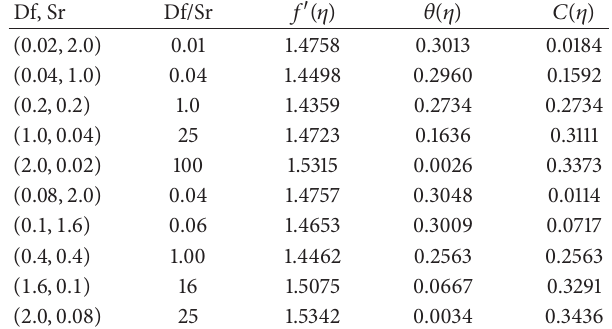
Table 1: Comparison of present results with values obtained by Cheng and Lin [20] for the melting strength 𝑀 = 2.0, 𝑁 = 0 , Df = 0, Sr = 0, and Le = 1.0 in the mixed convective strength with an aiding external flow.